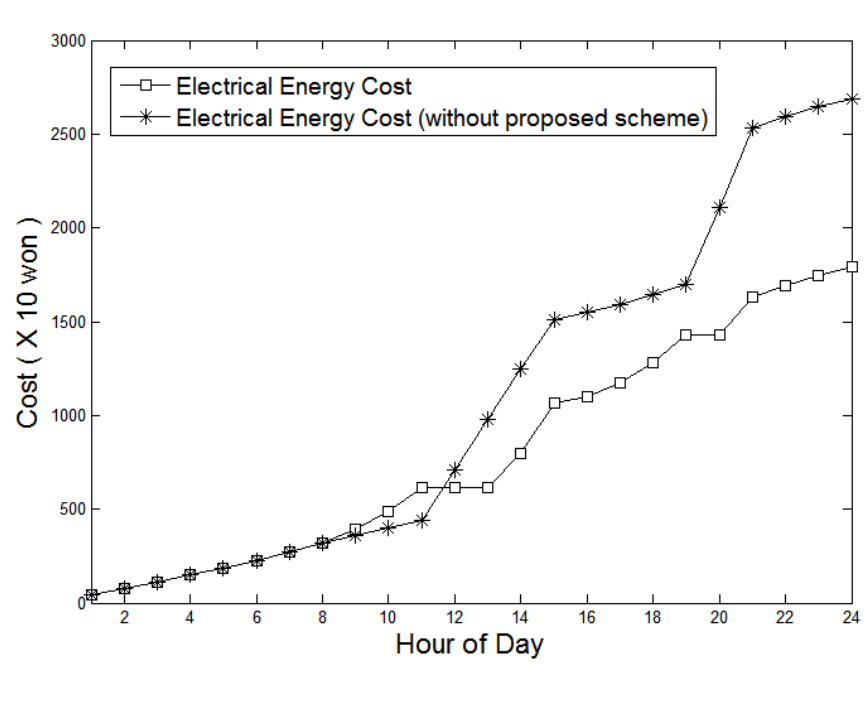
Figure 16. Comparison of electricity costs in Scenario